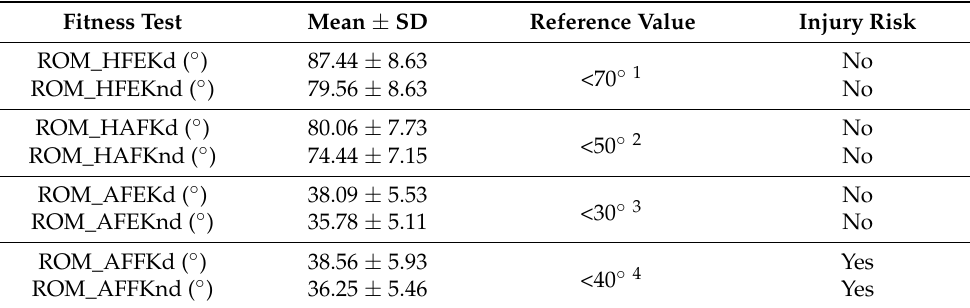
Table 4. Mean ROM values and derived injury risk. Fitness test